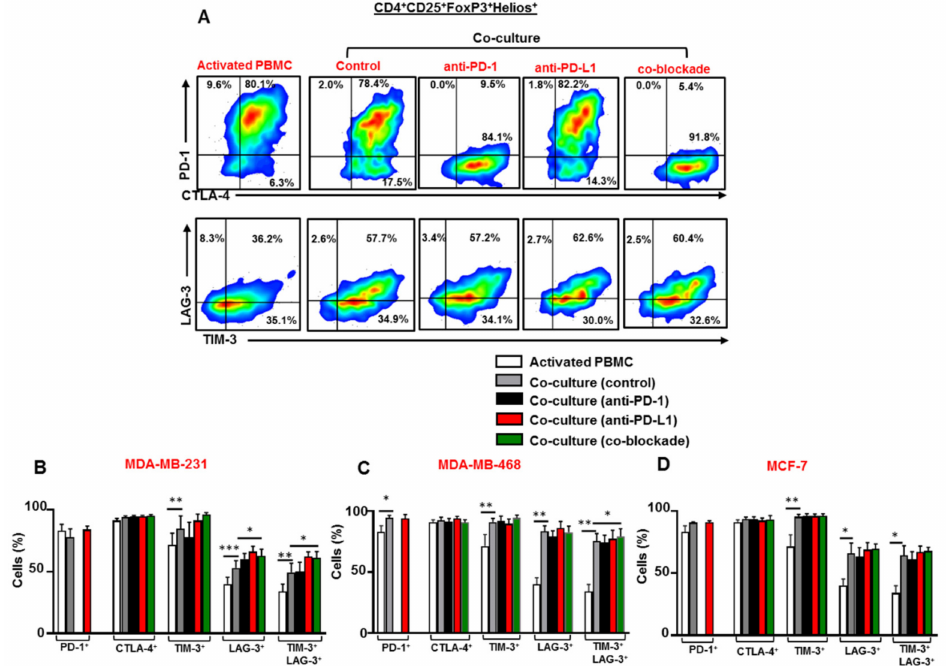
Figure 6. E ff ect of blocking PD-1 and PD-L1 on immune checkpoint expression in CD4 + CD25 + FoxP3 + Helios + Tregs. Activated PBMCs co-cultured with breast cancer cells were treated or untreated with 2 µ g / mL of anti-PD-1, 0.5 µ g / mL of anti-PD-L1 or with both mAbs. At 72 h post-mAb treatment cells were stained for immune checkpoints and FoxP3 / Helios expression, and analyzed by flow cytometry. Representative flow cytometric plots show the expression of PD-1, CTLA-4, TIM-3 and LAG-3 in Tregs from activated PBMC and MDA-MB-231 co-culture treated or untreated with mAb(s) ( A ). Bar plots show the di ff erences in IC expression on Tregs in the presence or absence of MDA-MB-231 ( B ), MDA-MB-468 ( C ) and MCF-7 ( D ) cells. Data represent the mean + SEM of four independent